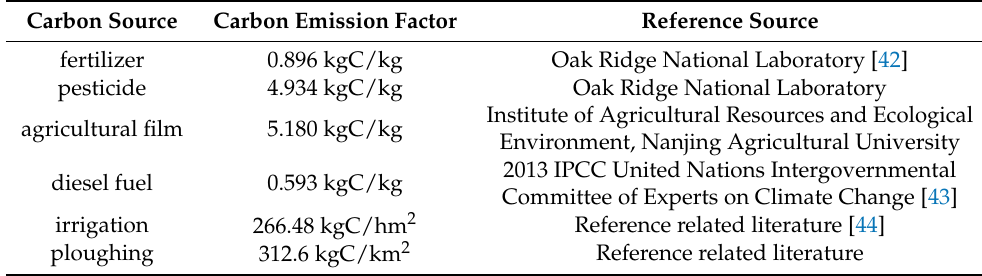
Table 1. Agricultural carbon emission sources, coefficients and reference